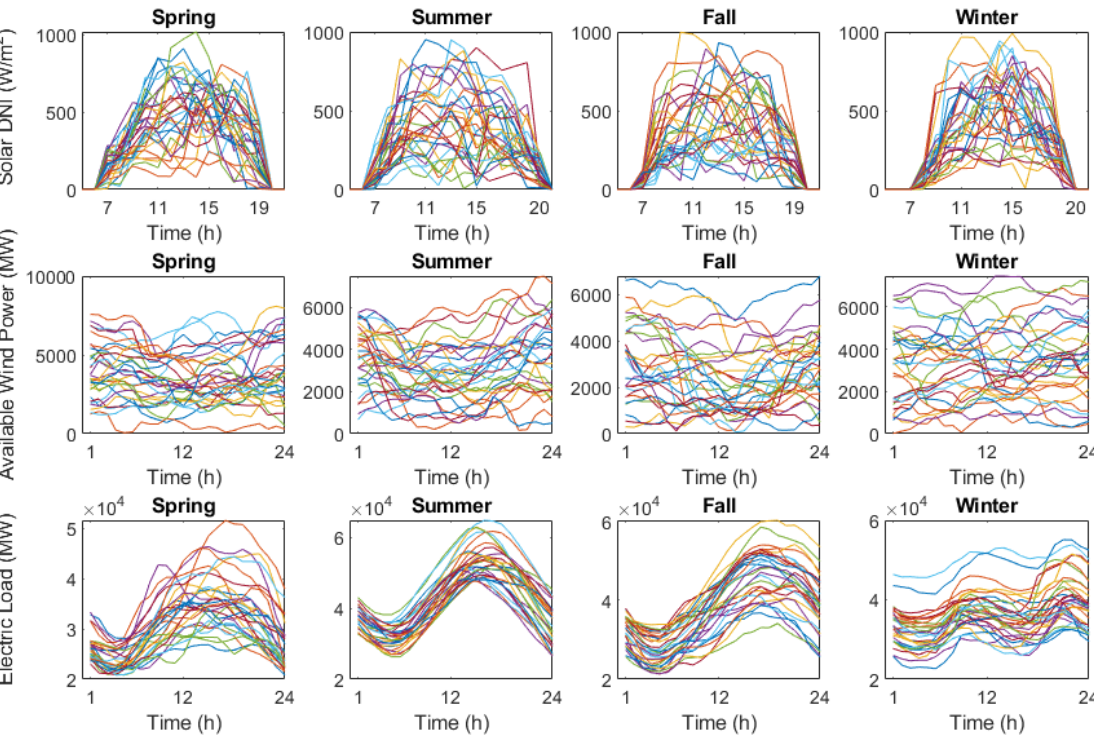
Figure 2. Generated hourly sample paths for four seasons with autoregressive-to-anything (ARTA)